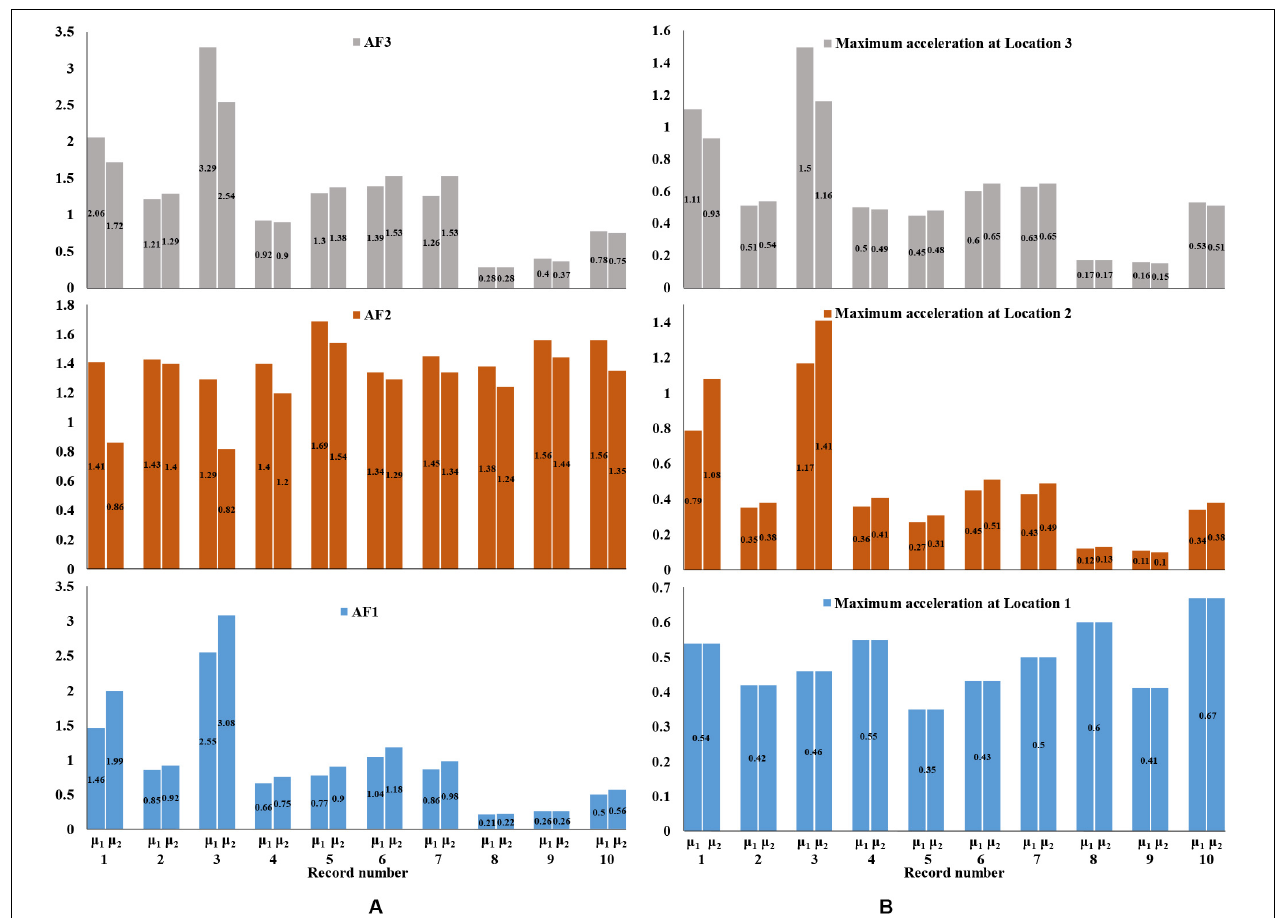
FIGURE 6 | Comparison of the amplification factors (A) and maximum accelerations (B) for the unanchored squat tank for two friction coefficients ( µ 1 = 0.4 and µ 2 = 0.7).